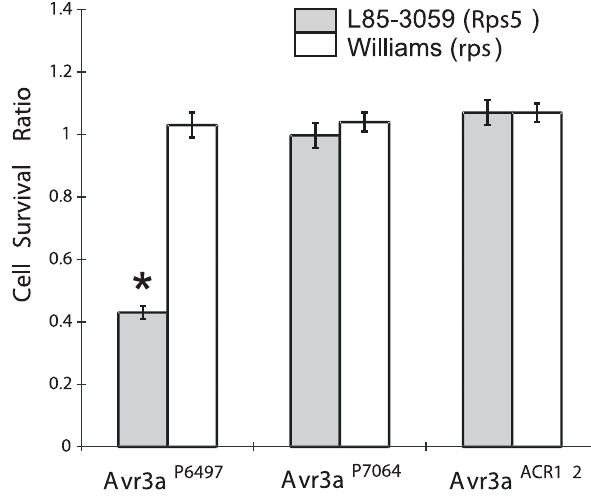
Figure 3. Expression of Avr3a P6497 in Rps 5 soybean plants can trigger cell death. Results from a co-bombardment assay are shown. The ratio of GUS-positive blue spots following co-bombardment with Avr3a P6497 , Avr3a P7064 and Avr3a ACR12 compared with the empty vector DNA. Expression constructs for Avr3a alleles were without signal peptides. Soybean lines Williams ( rps ) and L85–3059 ( Rps 5) are genetic isolines. Bars represent standard errors from 12–14 replicates each. An asterisk (*) indicates a significant difference (p , 0.001) by the Wilcoxon rank sum test.